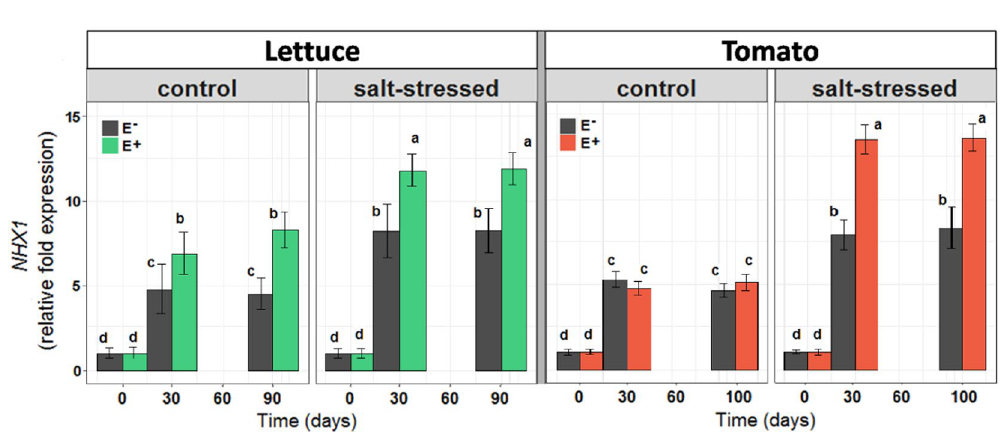
Figure 5. Effects of saline treatment (control vs. salt-stressed) and fungal inoculation (E − vs. E + plants) on the expression level of the NHX1 gene of lettuce and tomato plants along time. Different lowercase letters indicate, for each species separately, significant differences between treatments (Tukey HSD tests; α = 0.05). Values are means ± SE (n =